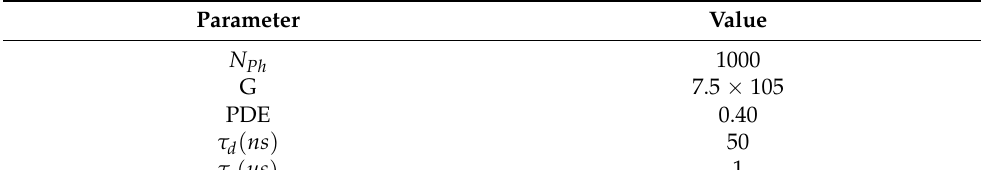
Table 1. Silicon photomultiplier (SiPM) current pulse parameters.